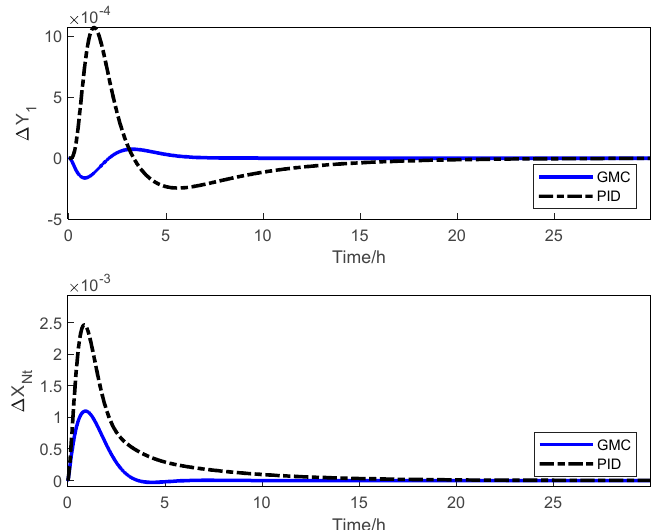
Figure 13. Response curve of controlled variable when the feed flow rate F +20% in Case 1.